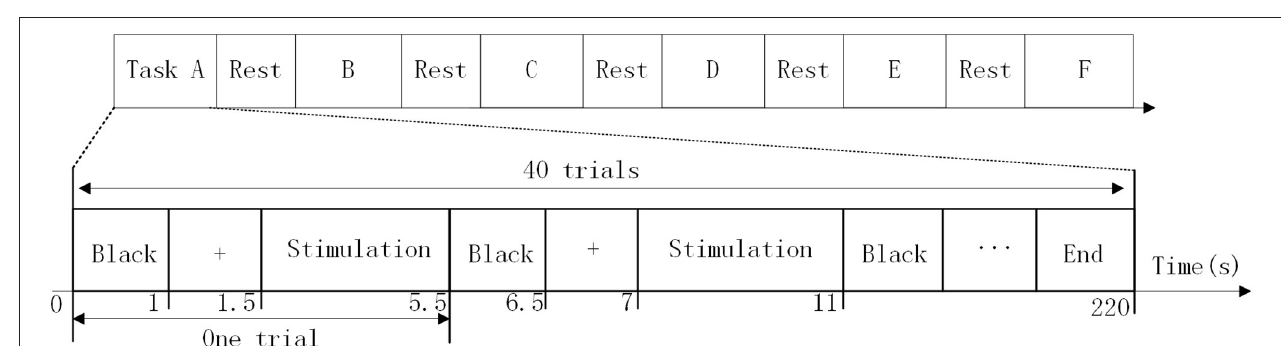
FIGURE 3 | Experimental time